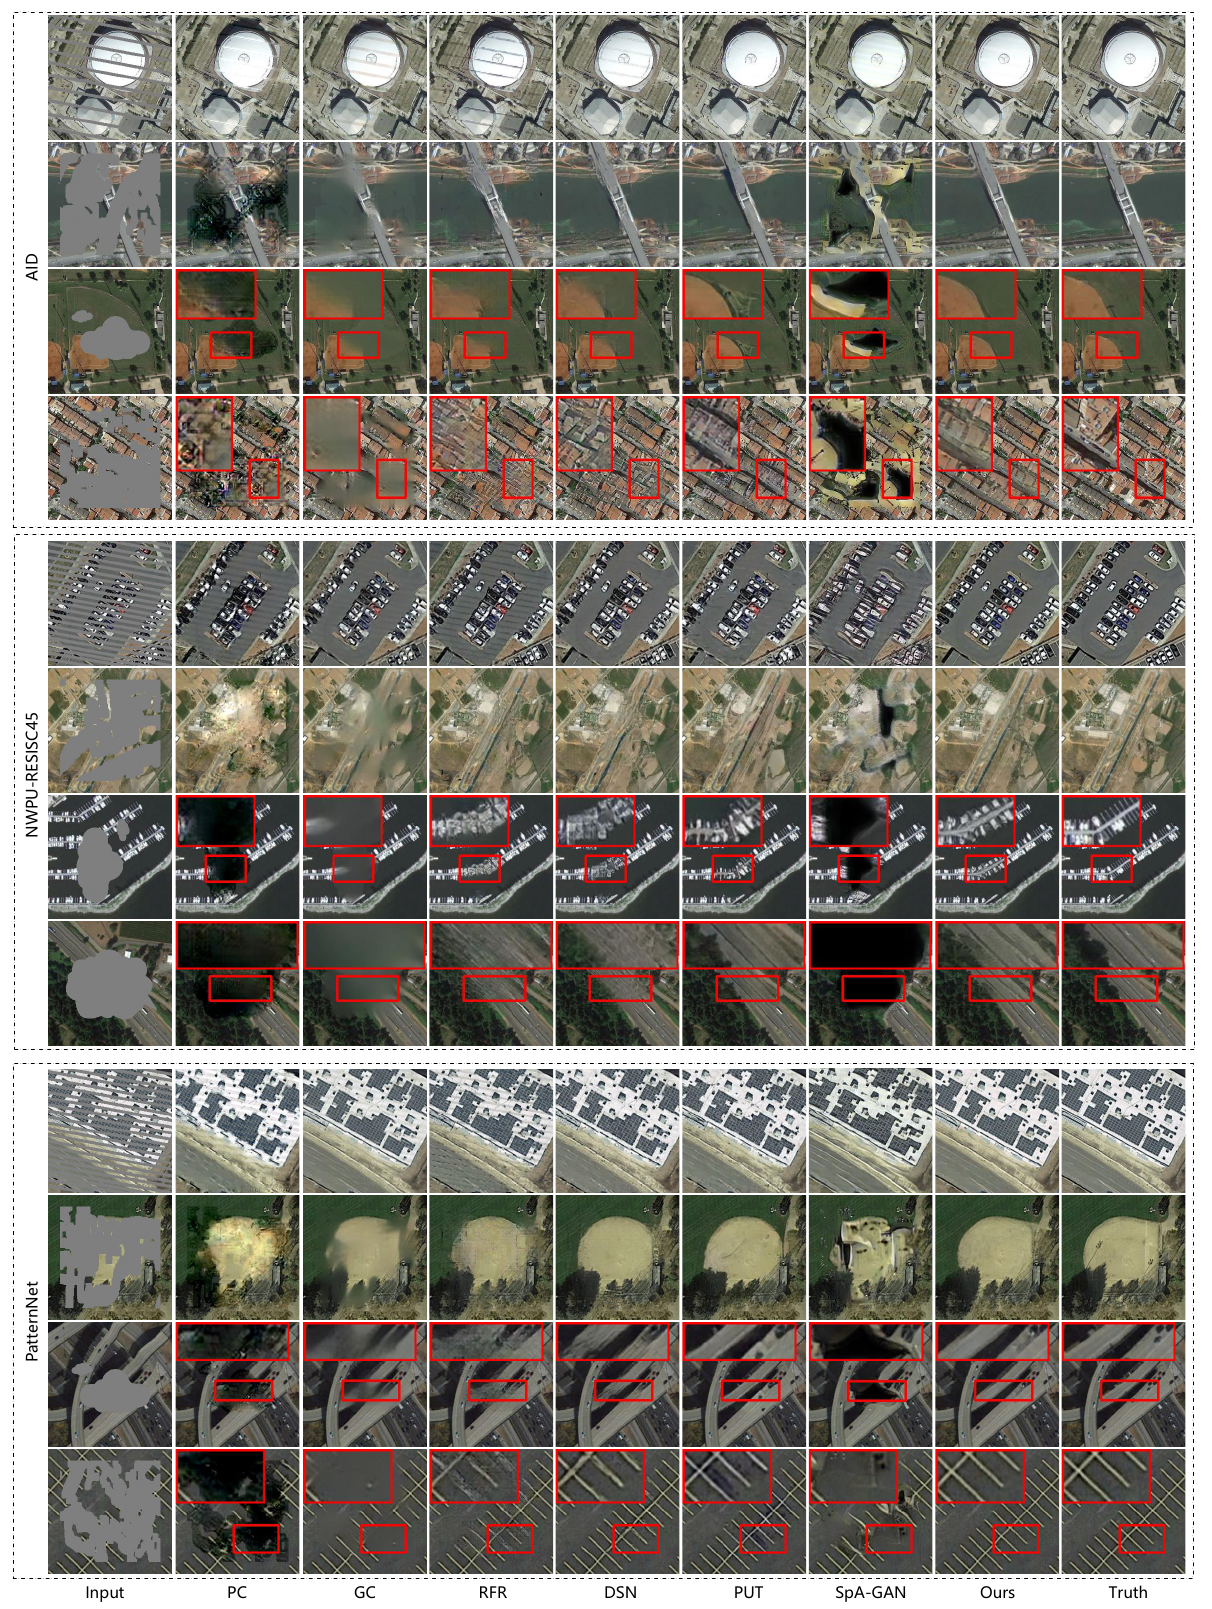
Figure 5. Qualitative results of remote sensing datasets (AID, NWPU-RESISC45, and PatternNet). Local details are displayed in the red